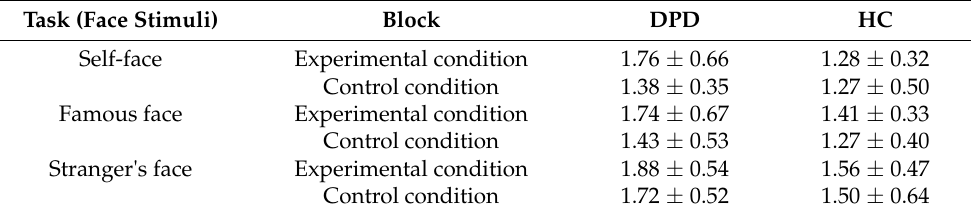
Table 2. The reaction times of patients with DPD and the HC when recognizing different faces. Task (Face Stimuli) Block DPD HC Self-face Experimental condition Famous face Experimental condition Control condition Stranger's face Experimental